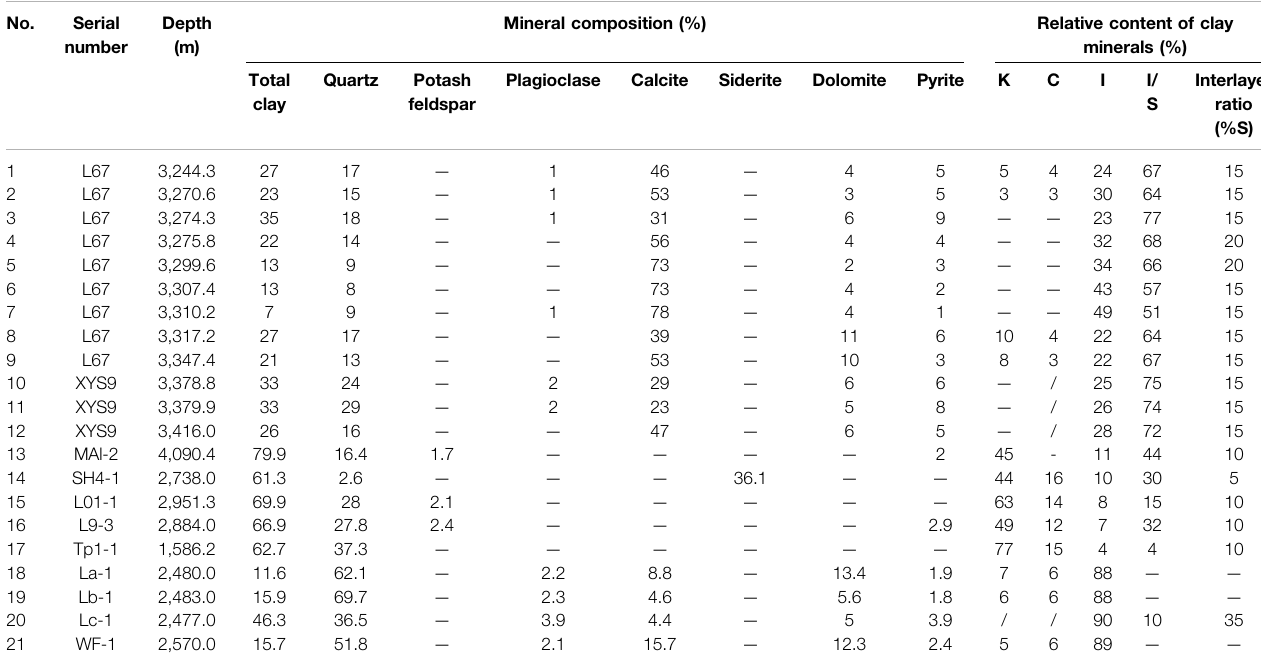
Mineral composition (%) Relative content of clay